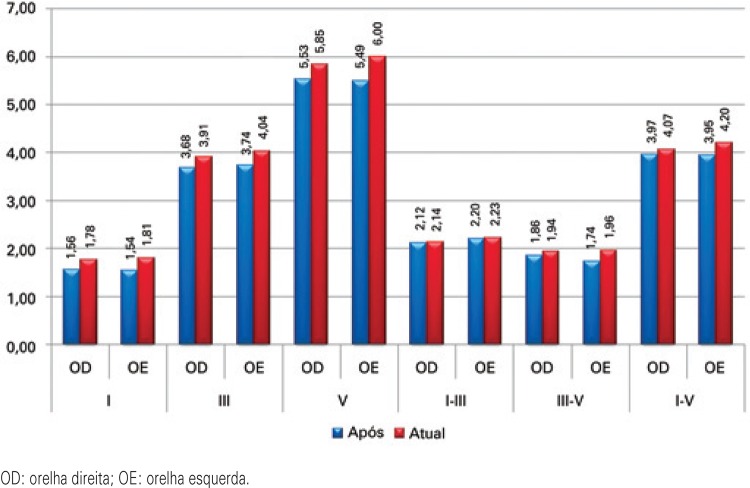
Latências absolutas médias das ondas I, III e V e dos intervalos interpicos I-III, III-V e I-V, nas avaliações após treinamento e atual